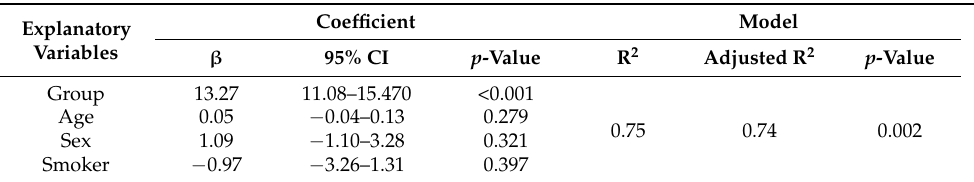
Table 3. Multiple linear regression model to estimate cytogenetic damage in function of the exposure, adjusted by